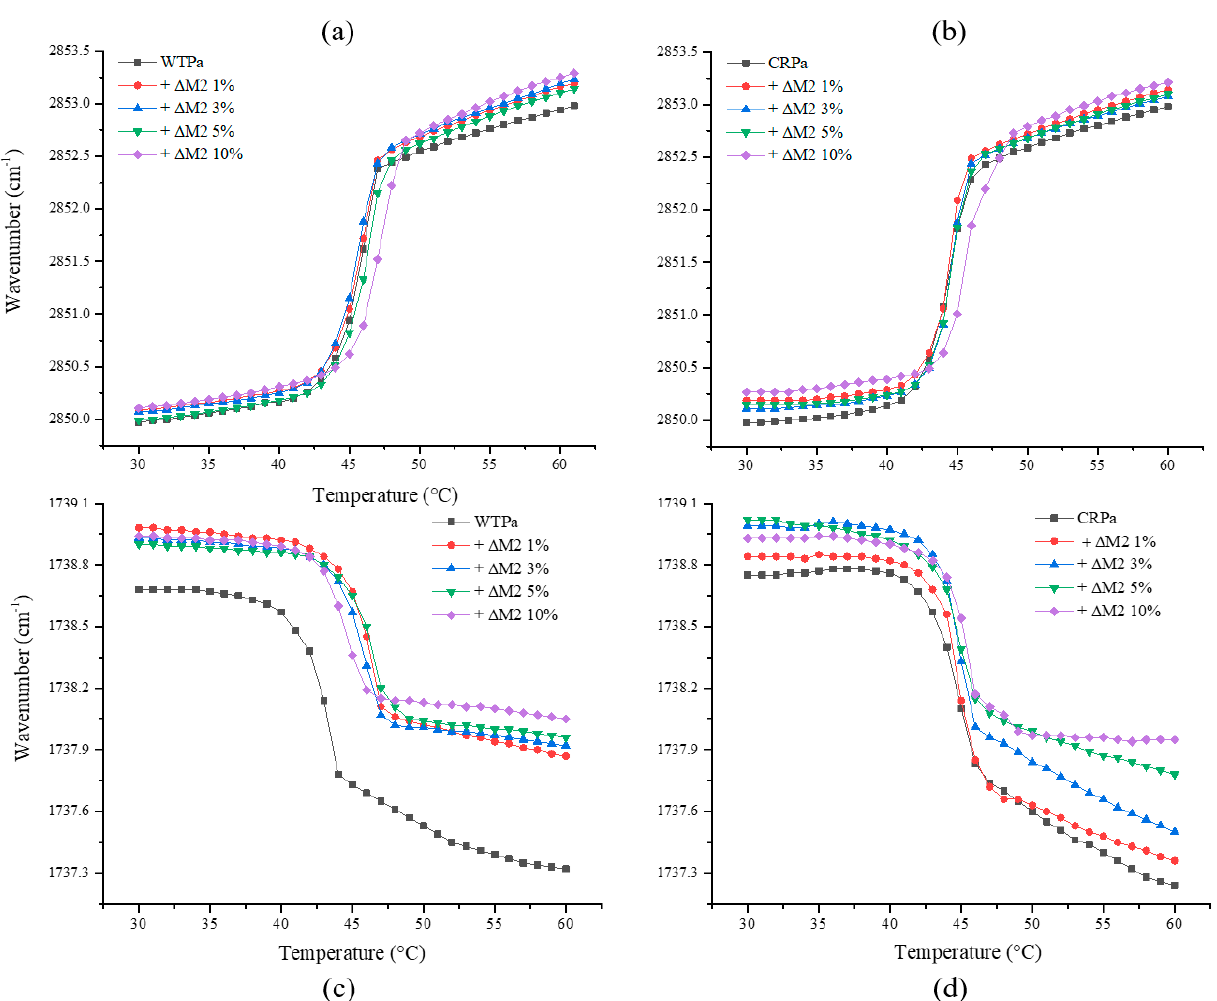
Figure 1. Peak positions of the symmetric stretching vibration bands of the methylene groups and stretching carbonyl vibration measured by FT-IR as a function of temperature. Panels ( a , b ) correspond to the ν s CH 2 vibration of P. aeruginosa (WTPa) and colistin-resistant P. aeruginosa (CRPa), respectively. Panels ( c , d ) correspond to the C=O vibrational bands of P. aeruginosa (WTPa) and colistin-resistant P. aeruginosa (CRPa) in the presence of different concentrations of Δ M2.